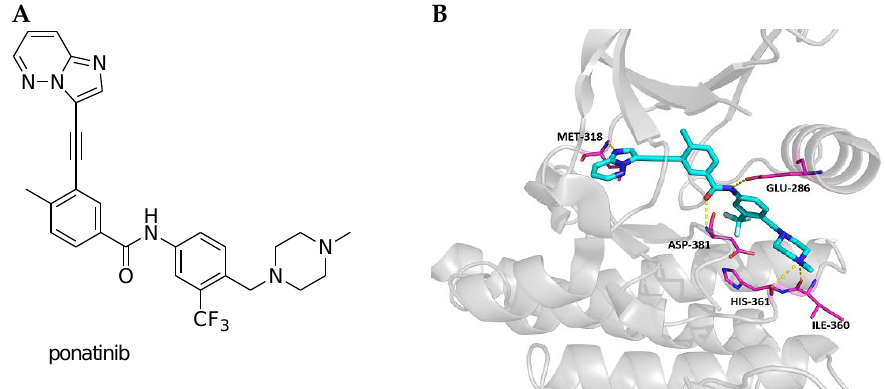
Figure 1. ( A ) Chemical structure of ponatinib. ( B ) Binding mode of ponatinib with Bcr-Abl. Hydrogen bonds are represented as yellow dashed lines.